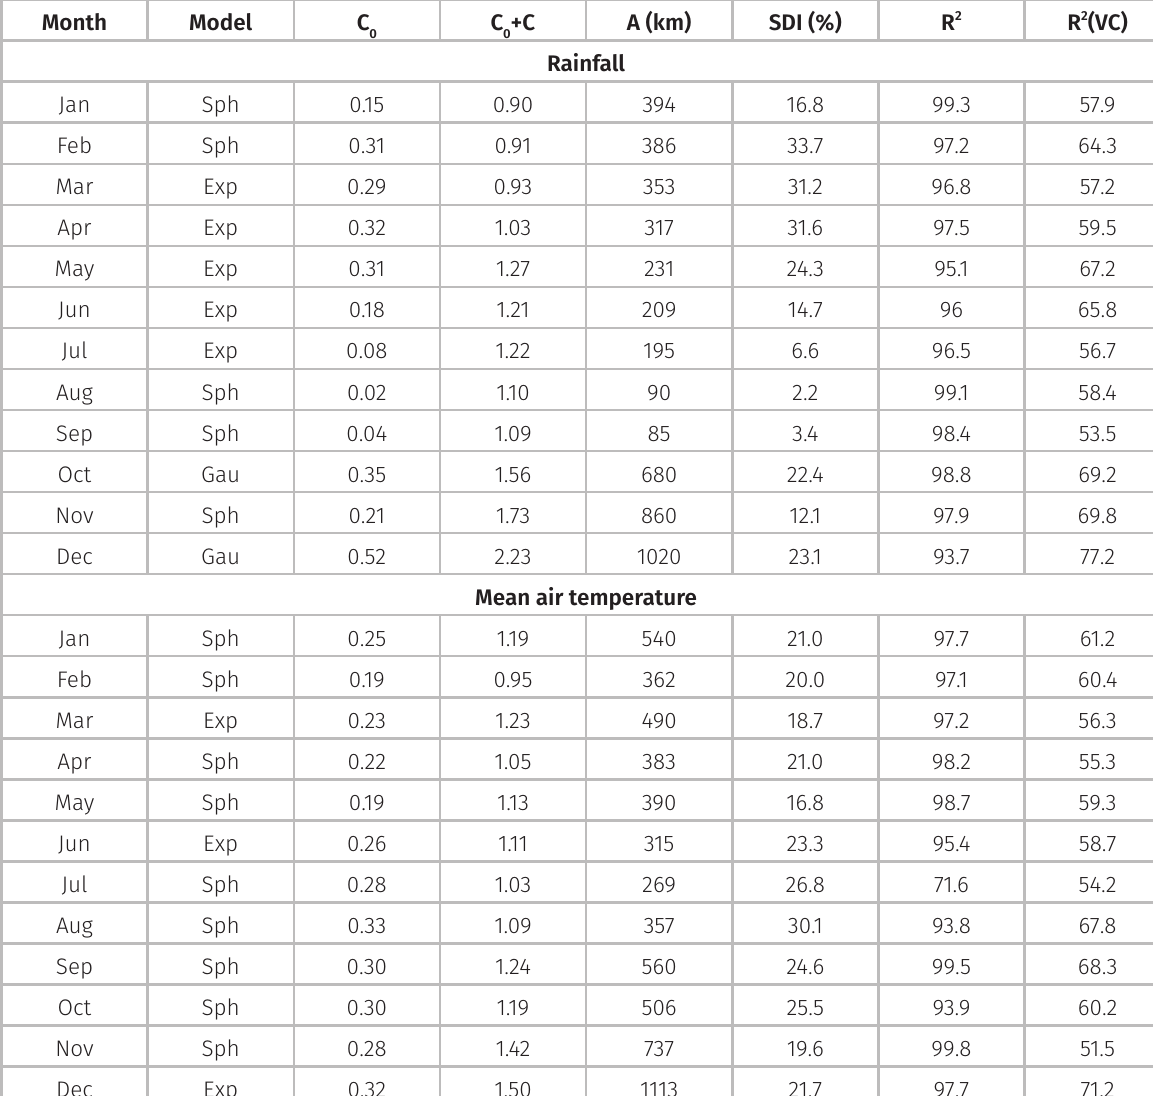
Table III. Models and parameters of the medium variograms adjusted for mean monthly rainfall and mean air temperature in the state of